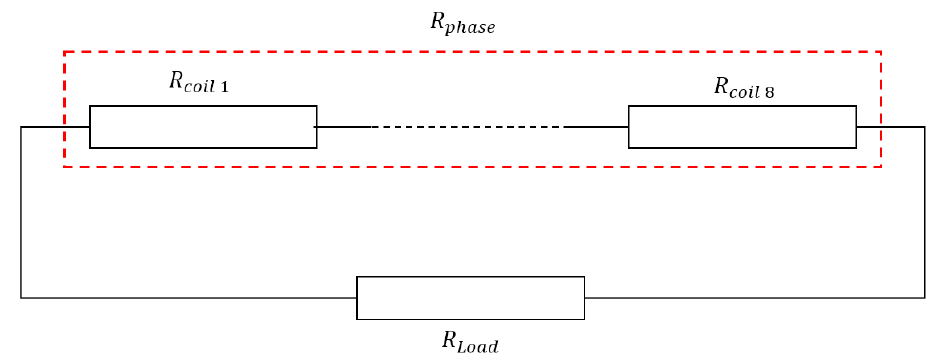
Figure 3. External circuit of the eight ‐ slot eight ‐ pole model.